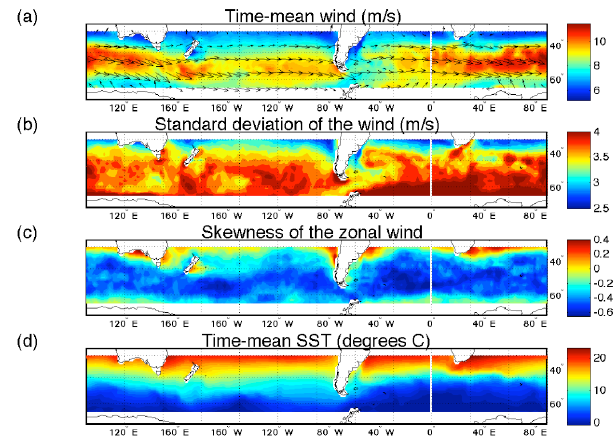
Figure 2. Low-order moments of SLW and SST anomalies: (a) time-mean SLW; (b) standard deviation of SLW; (c) skewness of the zonal component of SLW; and (d) time-mean SST.